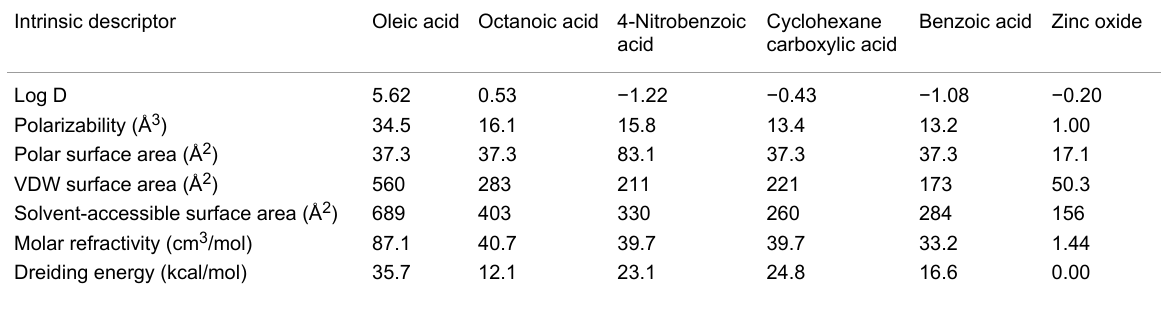
Table 2: Intrinsic properties of different surface chemistries.